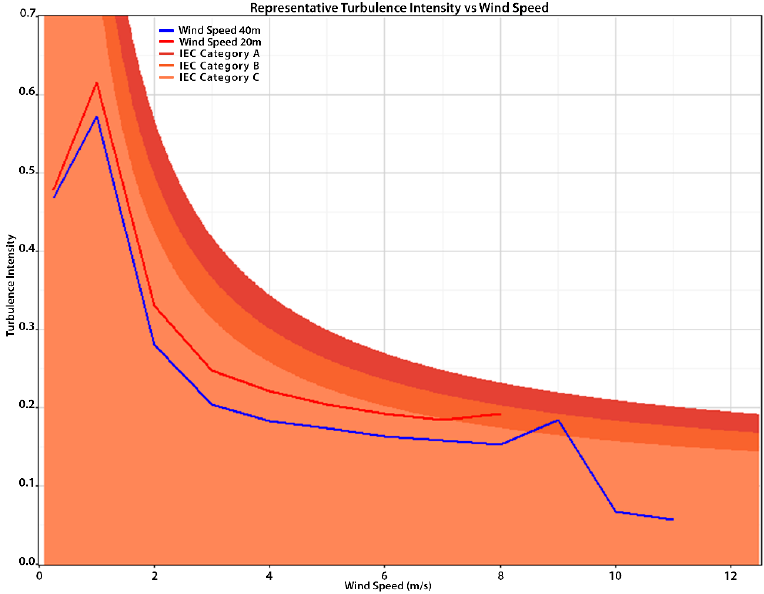
Figure 13. Comparison between wind speed and wind turbulence intensity. Source: generated by the software.